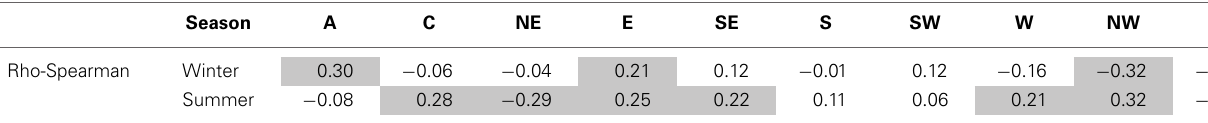
Table 1 | Trends in the different CWTs in the Iberian Peninsula (1950–2012).